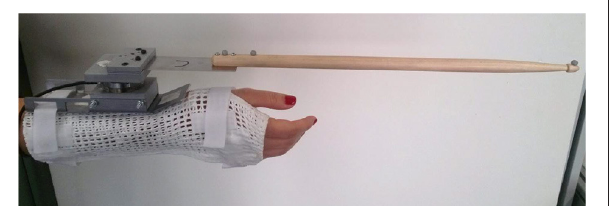
FIGURE 4 | Drumming cuff with a soft spring— The force-torque sensor as well as the markers for optical tracking of the drumstick can be seen. The cuff is designed such that it prevents the wrist from extension/flexion and radial/ulnar deviation.